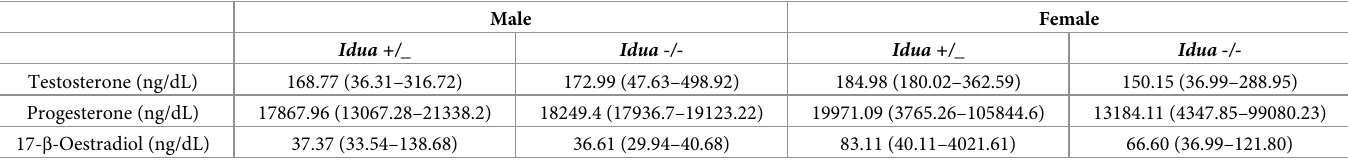
Table 1. Analysis of plasmatic levels of steroid hormones.